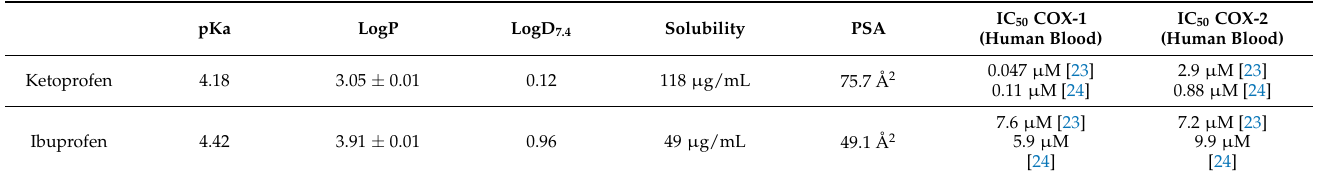
Table 1. Phys-chem properties and inhibitory activity on COX-1 and COX-2 of Ketoprofen and